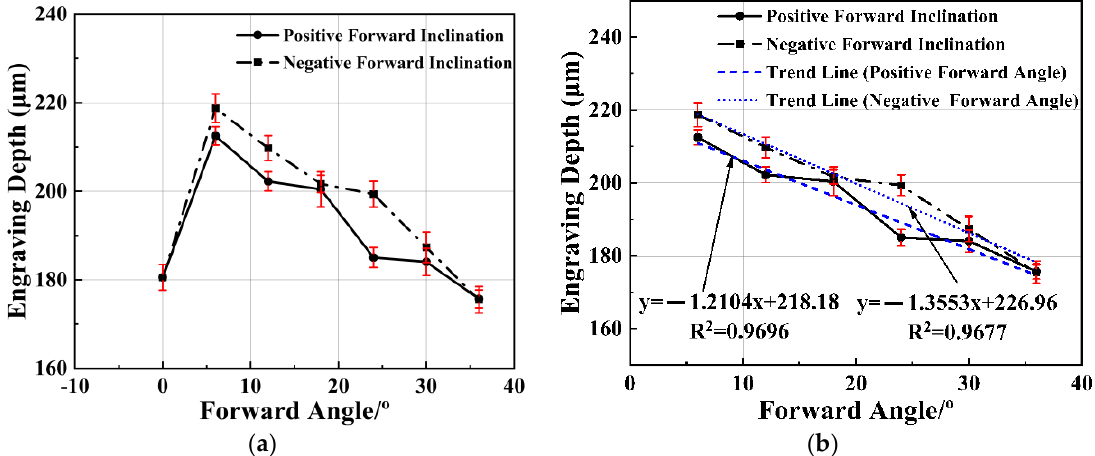
Figure 16. Relationship between forward angle and scribing depth. ( a ) Relationship between positive/negative forward inclination and scribing depth. ( b ) Relationship between positive/negative forward inclination and scribing depth without vertical angle